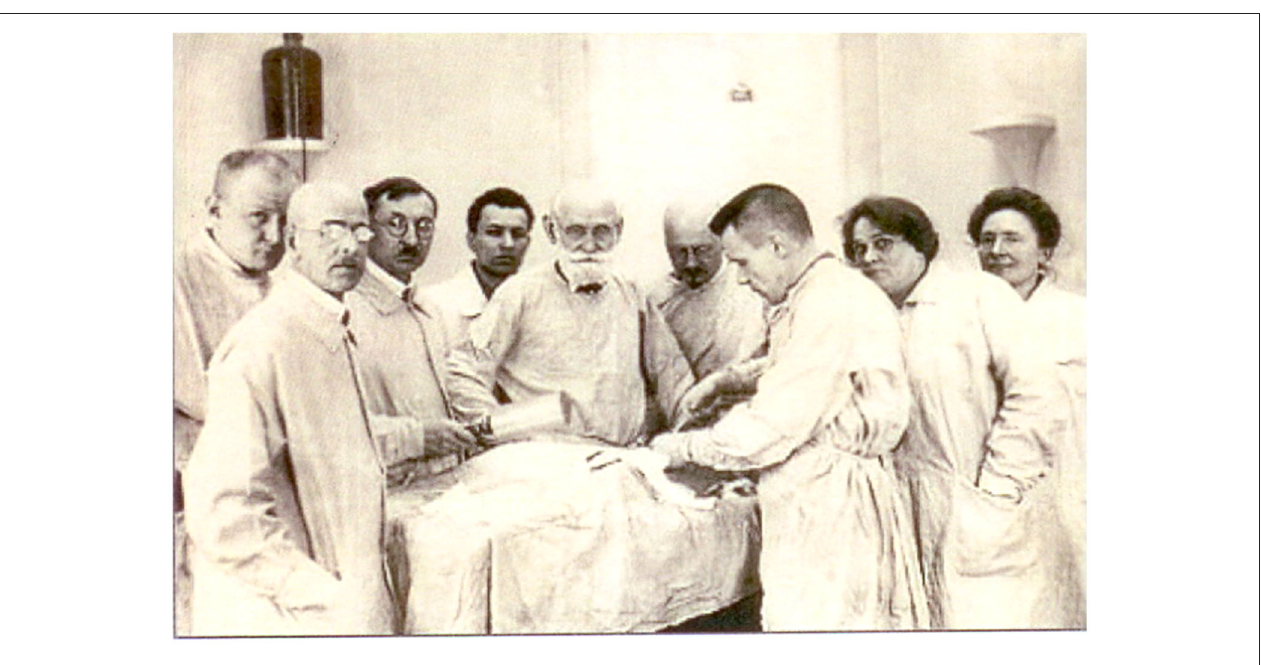
Alexander Speranskii (image reproduced with permission from The Institute of Experimental Medicine of the NorthWest Branch of the Russian Academy of Medical Sciences, St.